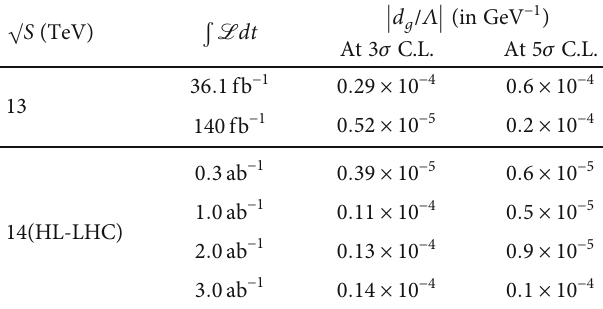
ffiffiffi p / Λ for = 13 TeV and 14TeV energy at S g Table 4: Sensitivity to CP-violating anomalous couplings at 3 σ C.L.